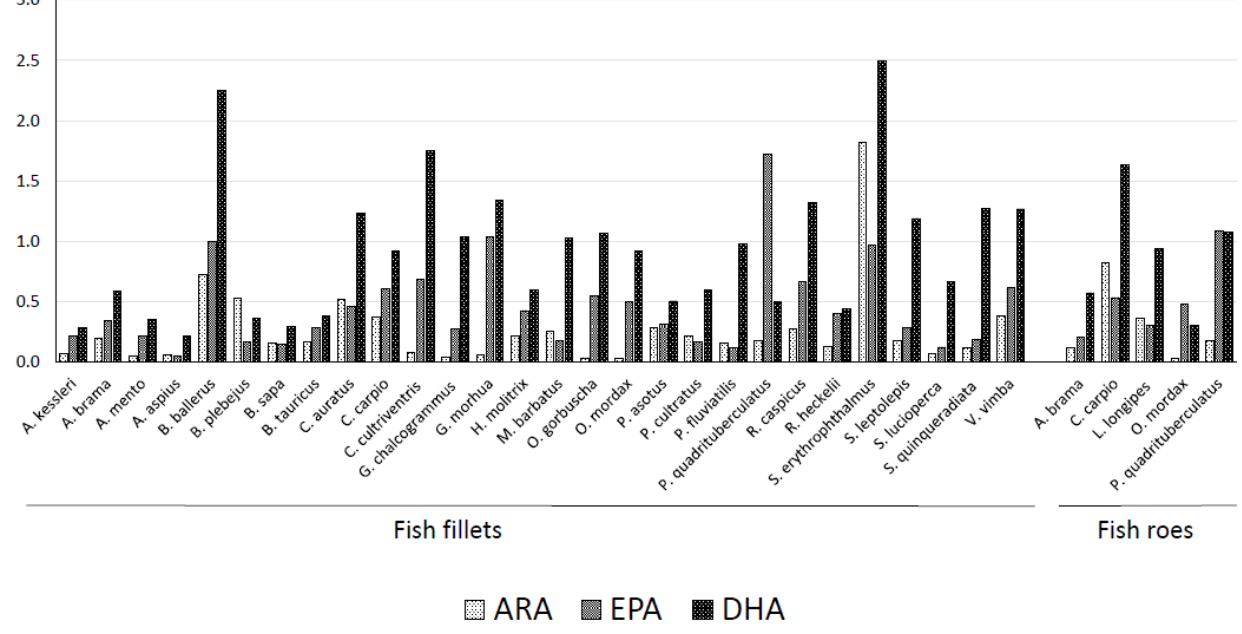
Figure 1. Concentrations of ARA, EPA, and DHA in the fillets and roes of dry-salted fishes analyzed in this work.